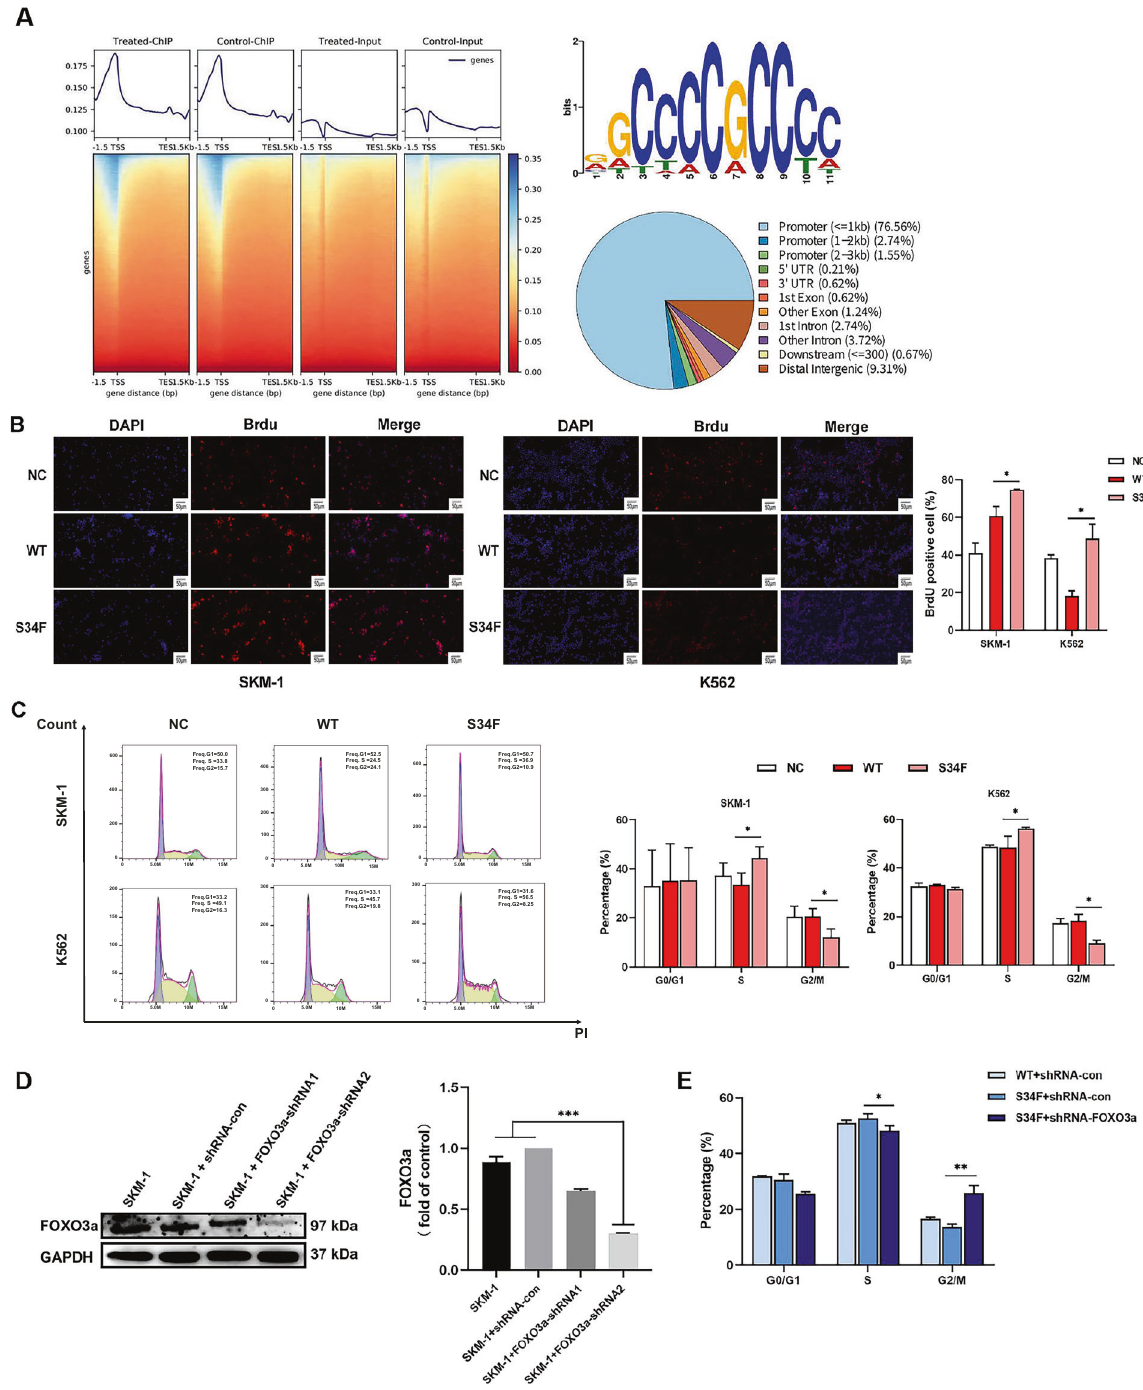
Fig. 4 S34F mutant U2AF1 induces G2/M cell cycle arrest mediated by FOXO3a activation. A ChIP-seq for FOXO3a binding to the promoter regions. Heatmaps and average intensity curves of ChIP assay reads for FOXO3a. B The representative micrographs and quanti fi cation of BrdU- incorporating cells (red) in both K562 and SKM-1 cell lines are shown. Nuclei counterstained with DAPI. Scale bar, 50 µm. C The representative fl ow cytometry analysis of the cell cycle distribution after ef fi cient transfection for 96 h in both K562 and SKM-1 cells. S34F mutant U2AF1 induced the increase in the proportion of S-phase cells and signi fi cantly reduced the percentage of cells at G2/M phase. D The knockout ef fi ciency for FOXO3a was determined by western blotting assays in SKM-1 cells. E Gene silencing of FOXO3a rescued the G2/M blocks induced by S34F mutant U2AF1 in SKM-1 cells. The data represent all experiments in triplicate for each cell line. *p < 0.05, ** p < 0.01, and *** p < 0.001. WT wild-type, NC negative controls. of NLRP3, ASC and active caspase-1 that were triggered by S34F the controls. The U2AF1 (S34F) mutant increased NLRP3 expres- mutant U2AF1 (Fig. 5E). Additionally, the expression level of Bim, sion, and the ASC and activated caspase-1 levels were also an apoptosis-related FOXO3a downstream target protein, was upregulated (Fig. 5D). Moreover, western blotting analysis decreased signi fi cantly after coinfection. Reactive oxygen species indicated that FOXO3a silencing signi fi cantly decreased the levels Cell Death and Disease (2021)